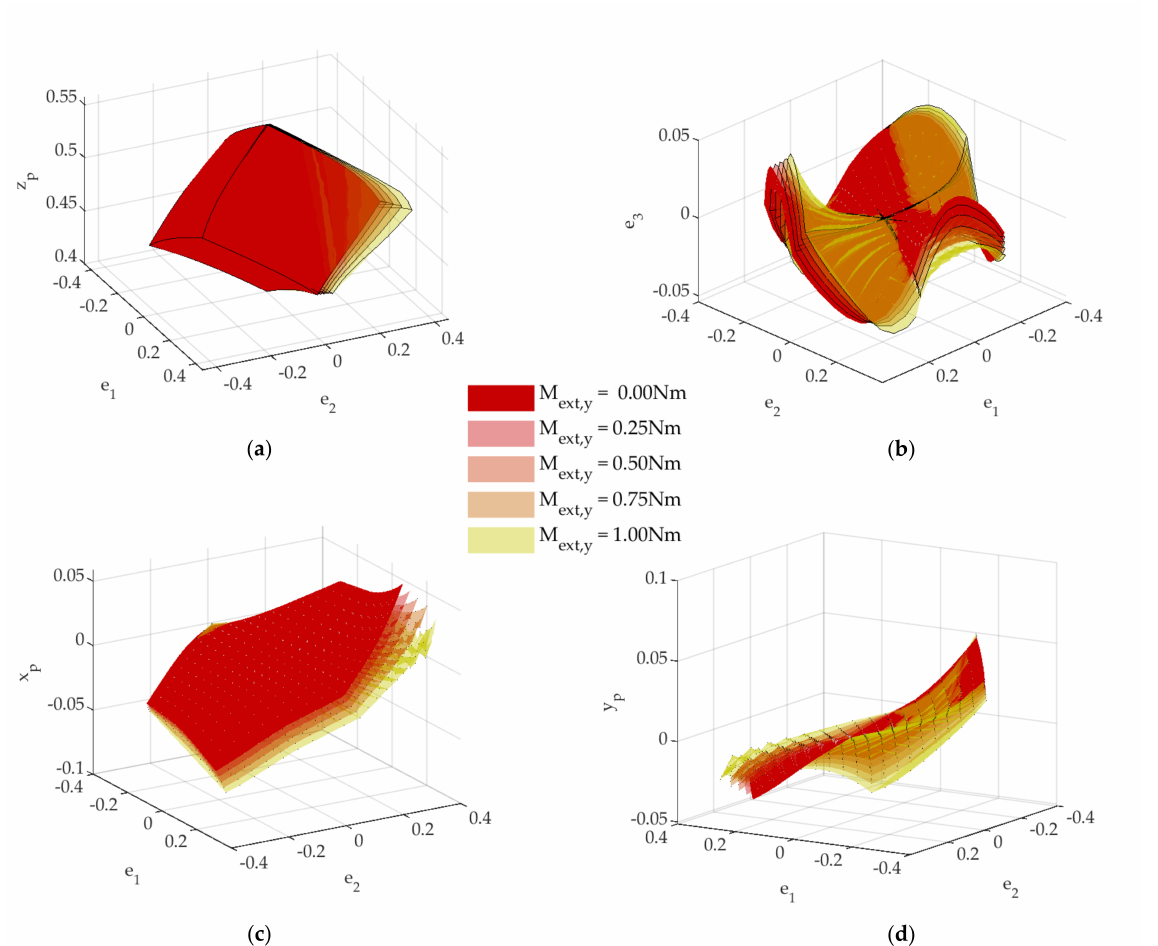
Figure 16. Influence of constant torques around the y axis of the fixed frame on the 3 PFS output parameters e 1 , e 2 , and z p ( a ), and parasitic motions e 3 ( b ), x p ( c ), and y p ( d ). Table 2. Relative RMS error of variables z p , e 3 , x p , and y p between loaded and unloaded case